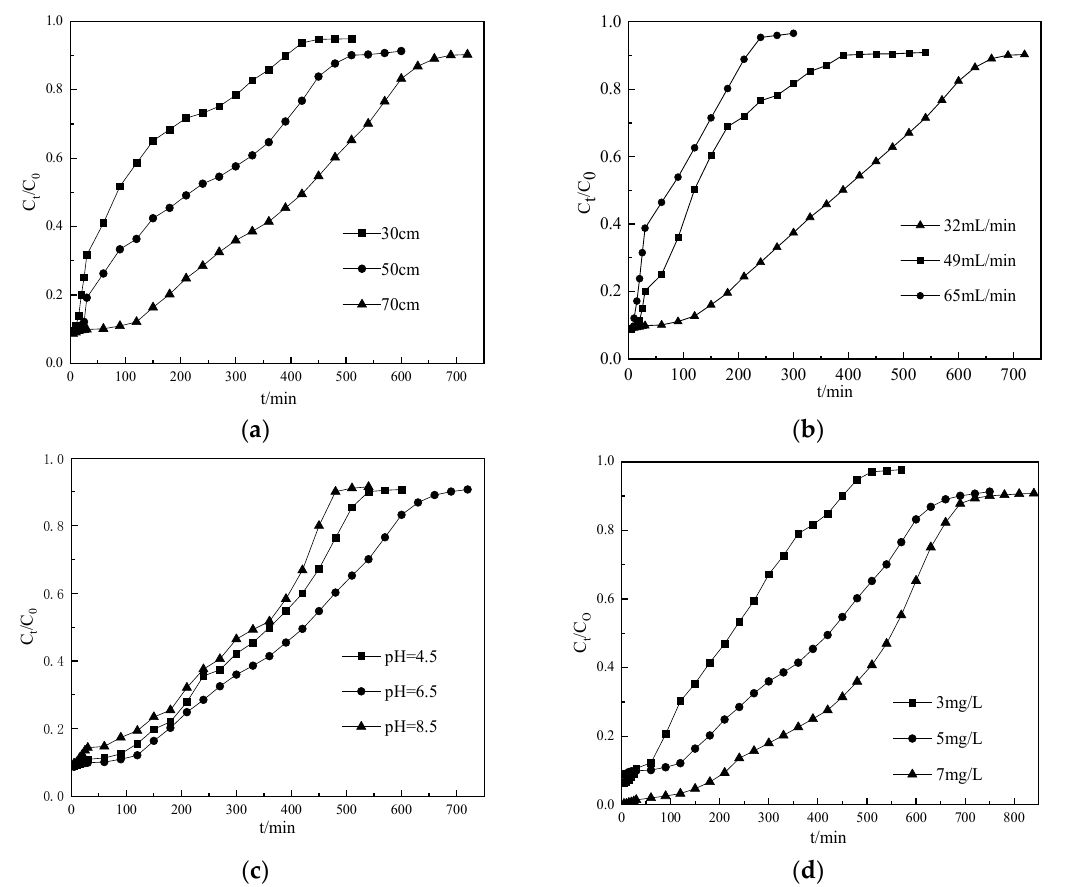
Figure 3. Breakthrough curves of ammonium nitrogen at different ( a ) bed depth, ( b ) flow rate, ( c ) influent pH, ( d ) initial ammonium nitrogen concentration from a fixed-bed column packed with CTS-ZMS. Table 3. Experimental parameters of the ammonium nitrogen adsorptive removal in the fixed-bed column packed with CTS-ZMS. Experimental Conditions Thomas